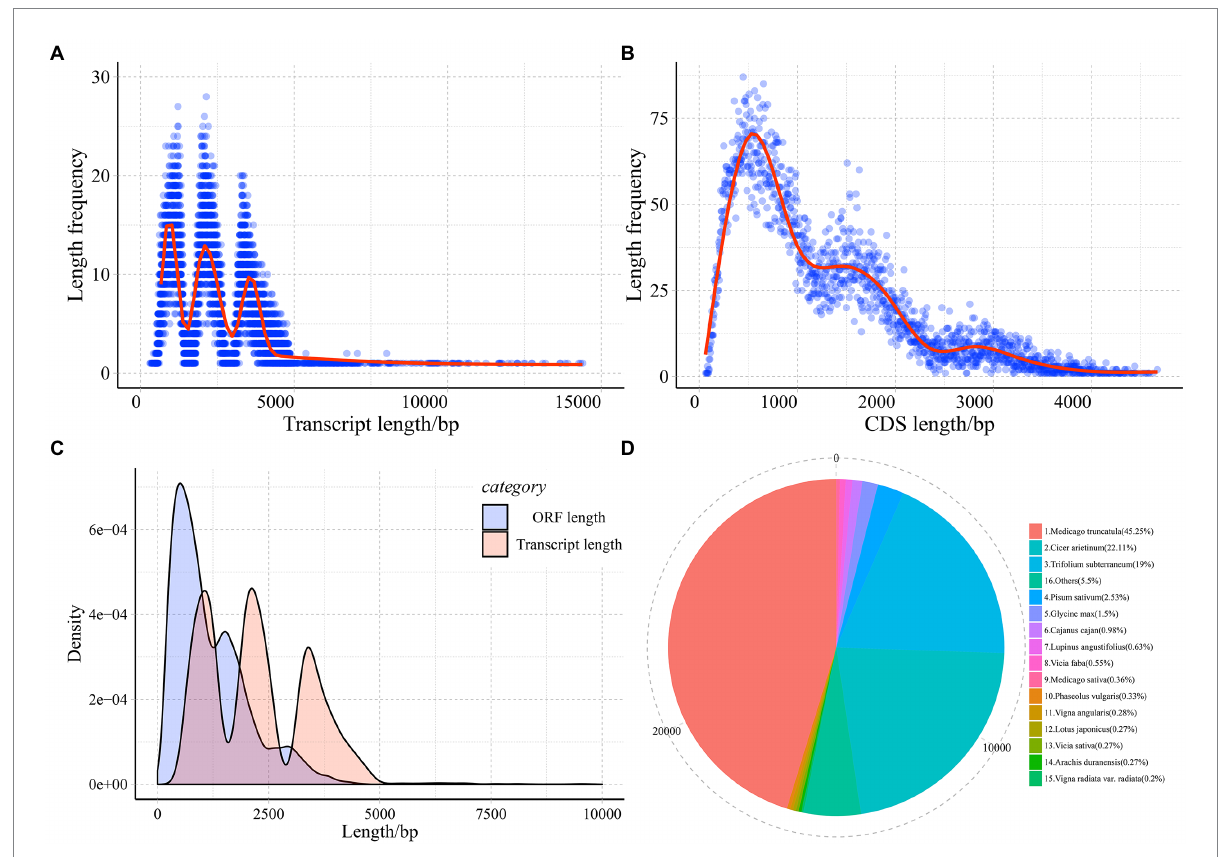
FIGURE 1 Length distribution of the assembled transcript (A) , CDS (B) , frequency distribution comparison of transcript and CDS (C) , and annotation distribution (D)